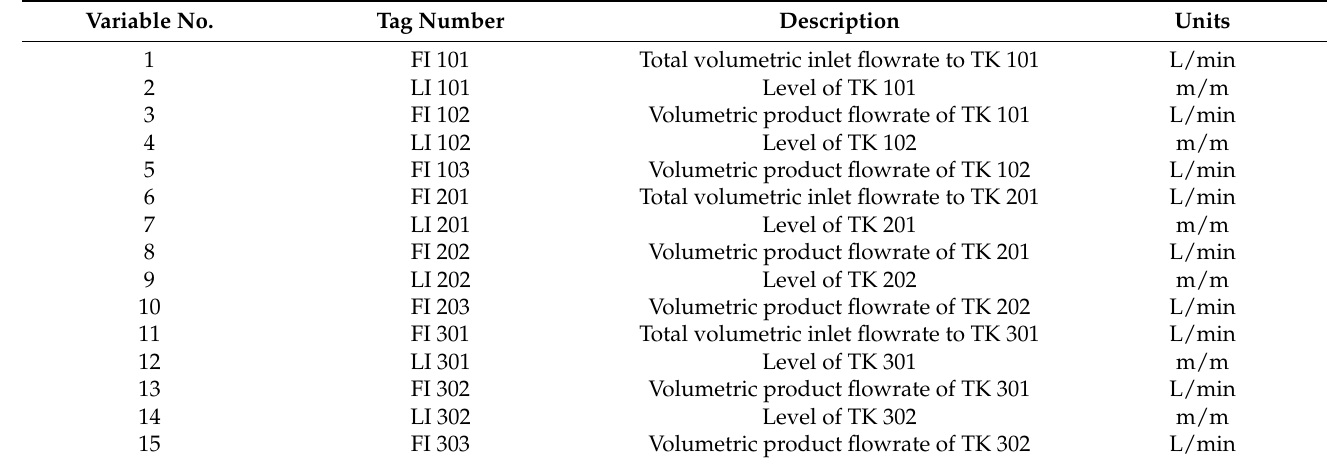
Table 1. List of measured variables in simulated tank network case study. The first number in each tag name indicates its PS. Variable No. Tag